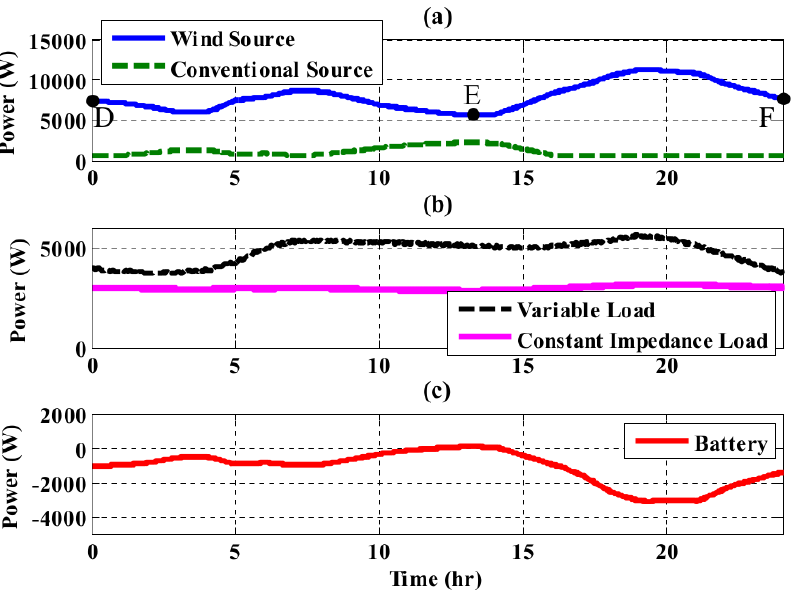
Figure 19. Simulation results using multidimensional droop control: ( a ) power supplied by each source; ( b ) power consumed by each load; and ( c ) power supplied by the